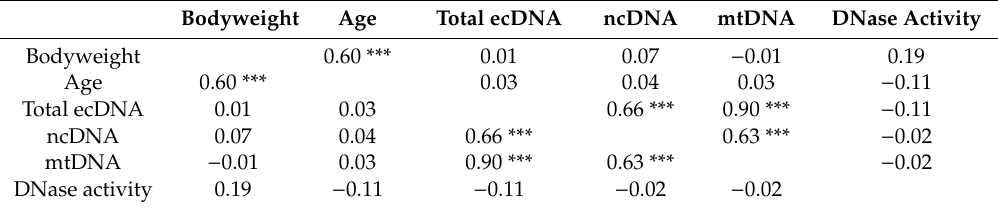
Table 2. Correlation matrix describing the relationships between the analyzed variables, namely: bodyweight, age, total extracellular DNA (ecDNA), nuclear ecDNA (ncDNA), mitochondrial ecDNA (mtDNA), and deoxyribonuclease (DNase) activity. The data in the table are presented as Pearson’s correlation coefficients with p -values indicated as p ˂ 0.001 for ***.